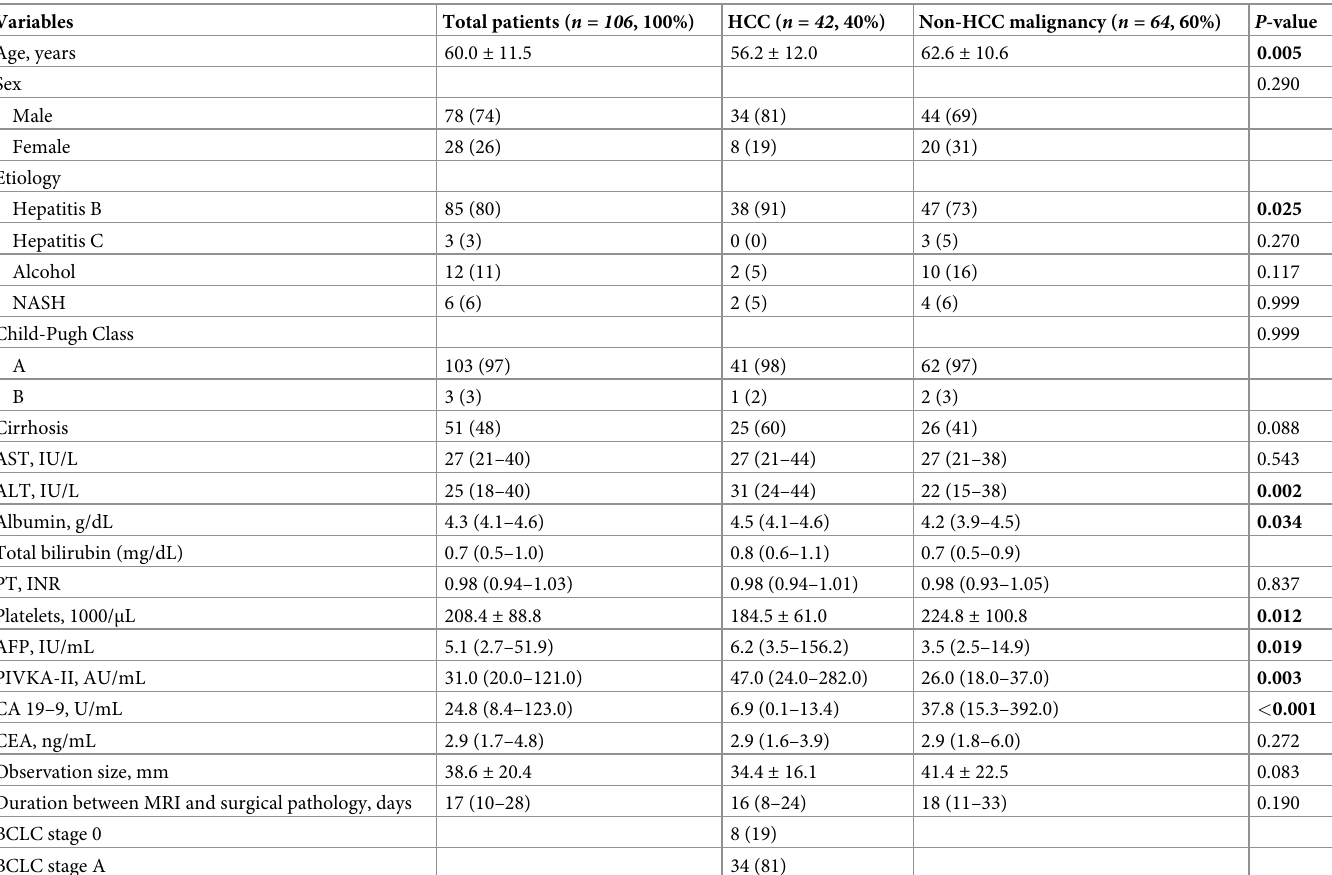
Table 1. Baseline characteristics of the included